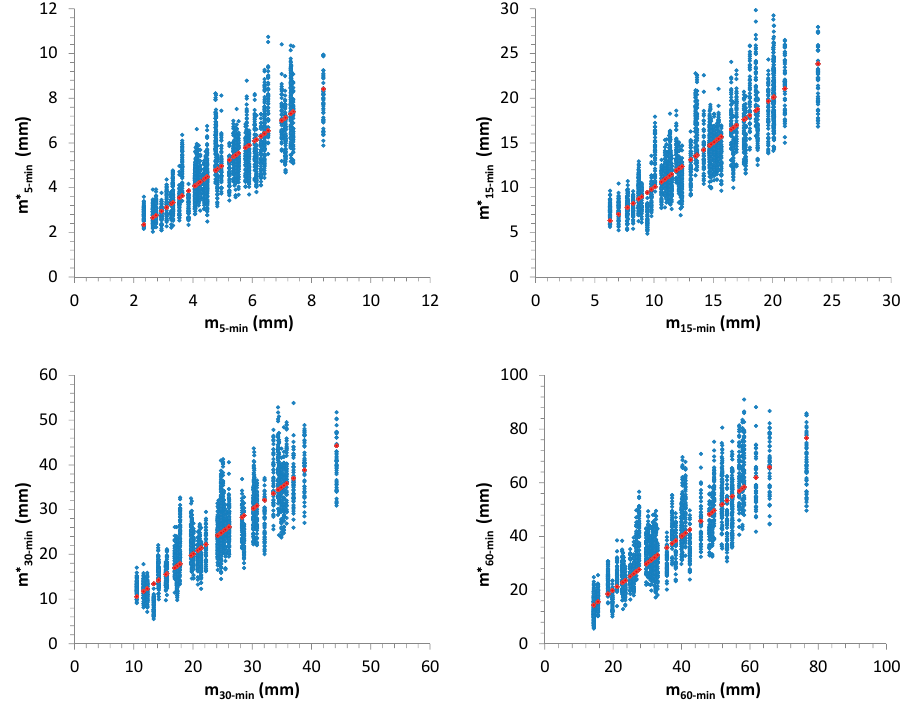
Figure 13. Scatter plots showing the relationship among starting values for ε (horizontal axis) and their associated distribution (indicated with the superscript * and reported on vertical axis). The red dots indicate the 1:1 line.